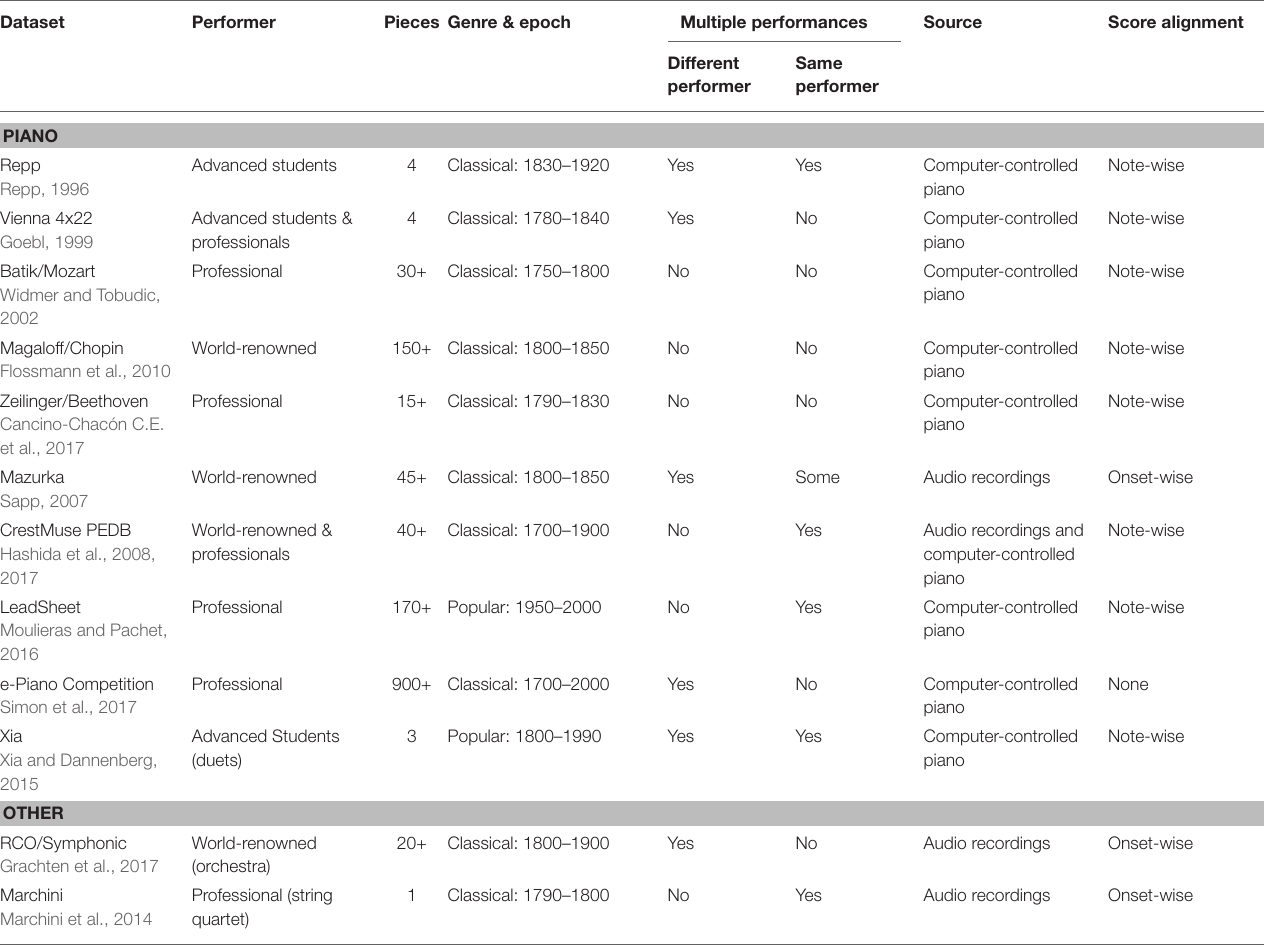
TABLE 4 | Datasets of expressive